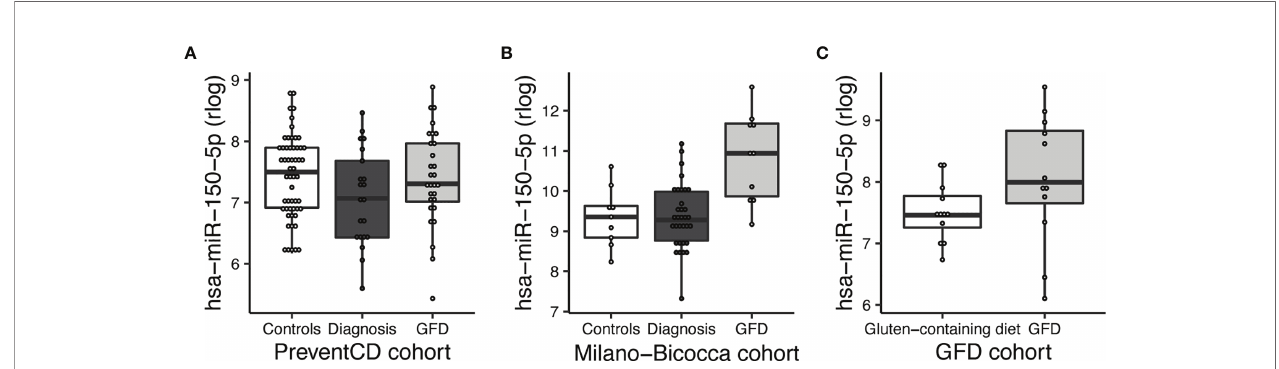
FIGURE 7 | MiR-150-5p is signi fi cantly decreased in CeD and reverses after start of a GFD. (A) PreventCD: high-risk controls and CeD patients at time of diagnosis (taken at seroconversion or at time of biopsy) and CeD patients after start of a GFD. (B) Milano-Bicocca cohort: controls at time of diagnosis (CeD) and at GFD. (C) GFD volunteers: on gluten-containing diet or